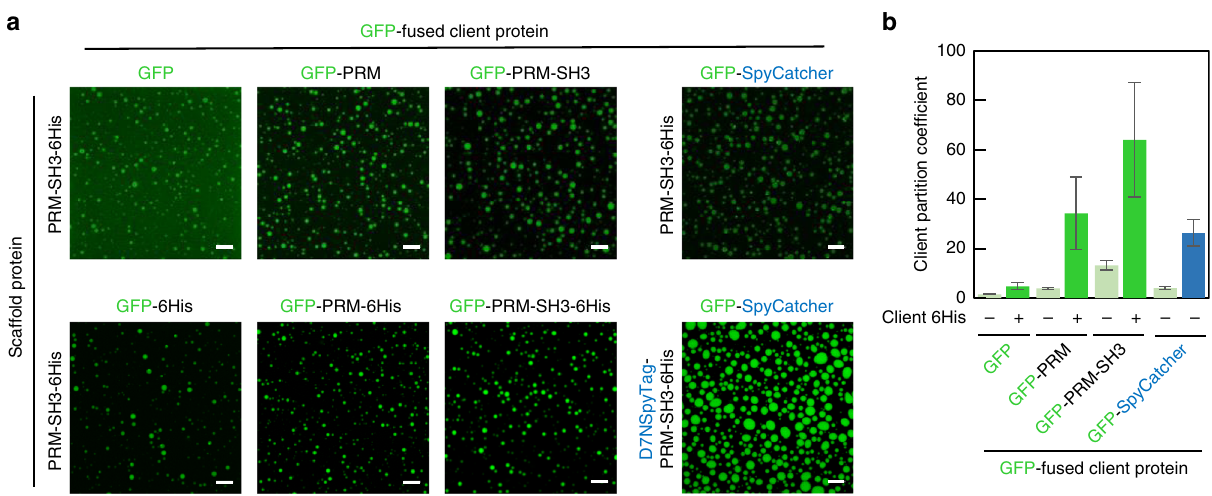
Fig. 3 Client recruitment control into protein condensates. a Fluorescence images of GFP-fused client recruitment into PRM-SH3-6His (or D7NSpyTag- PRM-SH3-6His) condensates. Scaffold proteins (100 μ M) and client proteins (3 μ M) were mixed with Ni 2 + (20 μ M), and incubated for 60 min before confocal analysis. Scale bars: 10 μ m. b Client PC values for various GFP-fused clients. PC on D7NSpyTag-PRM-SH3-6His condensates is indicated with a blue bar. Error bars: 1 s.d. ( n =